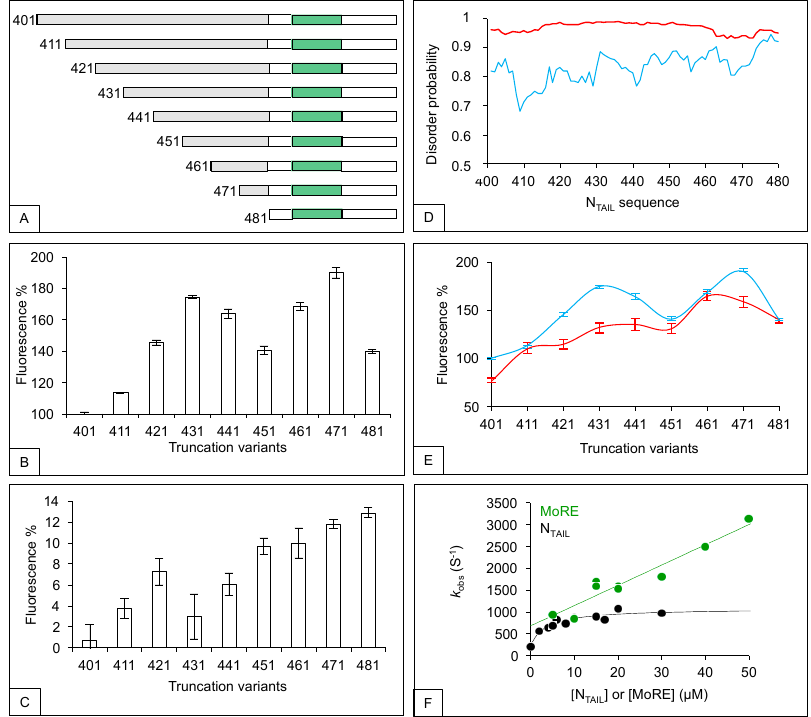
Figure 2. Effect of the N-terminal fuzzy region of N TAIL on XD and hsp70 binding. ( A ) N TAIL deletion variants were generated as described [60]. The N-terminal residue is indicated. The N-terminal fuzzy region subjected to truncation is shown in grey and the MoRE is shown in green. ( B , C ) Split- green fluorescent protein (GFP) complementation assay using XD ( B ) and hsp70 ( C ). Shown are the mean values and standard deviation (SD) of an experiment performed in triplicate. Results are expressed as percentage with 100% being the fluorescence value provided by full-length N TAIL (401). For a detailed description of the procedure see Supplementary Information. ( D ) IUPred [64] disorder prediction of wtN TAIL (blue) and artN TAIL (red) from residue 401 to residue 480. ( E ) Fluorescence values obtained by split-GFP complementation assays using wild type (wt) (blue line) and art (red line) N TAIL truncation variants and XD. Shown are the mean values and SD of an experiment performed in triplicate. Results are expressed as percentage with 100% being the fluorescence value provided by full-length wtN TAIL (401). ( F ) Binding kinetics of XD (at a constant concentration of 2 µ M) with excess concentrations of either wtNTAIL (black circles) or a peptide mimicking the MoRE (green circles) in 10 mM sodium phosphate buffer and 150 mM NaCl at pH 7.0. Under all conditions, there was an at least fivefold difference in concentration between the two proteins to ensure pseudo-first order conditions. Experiments were carried out using a PTJ-64 capacitor-discharge T-jump apparatus (Hi-Tech, Salisbury, UK). The temperature was rapidly changed with a jump size of 9 ◦ C, from 11 ◦ C to 20 ◦ C. Data were taken from [60].